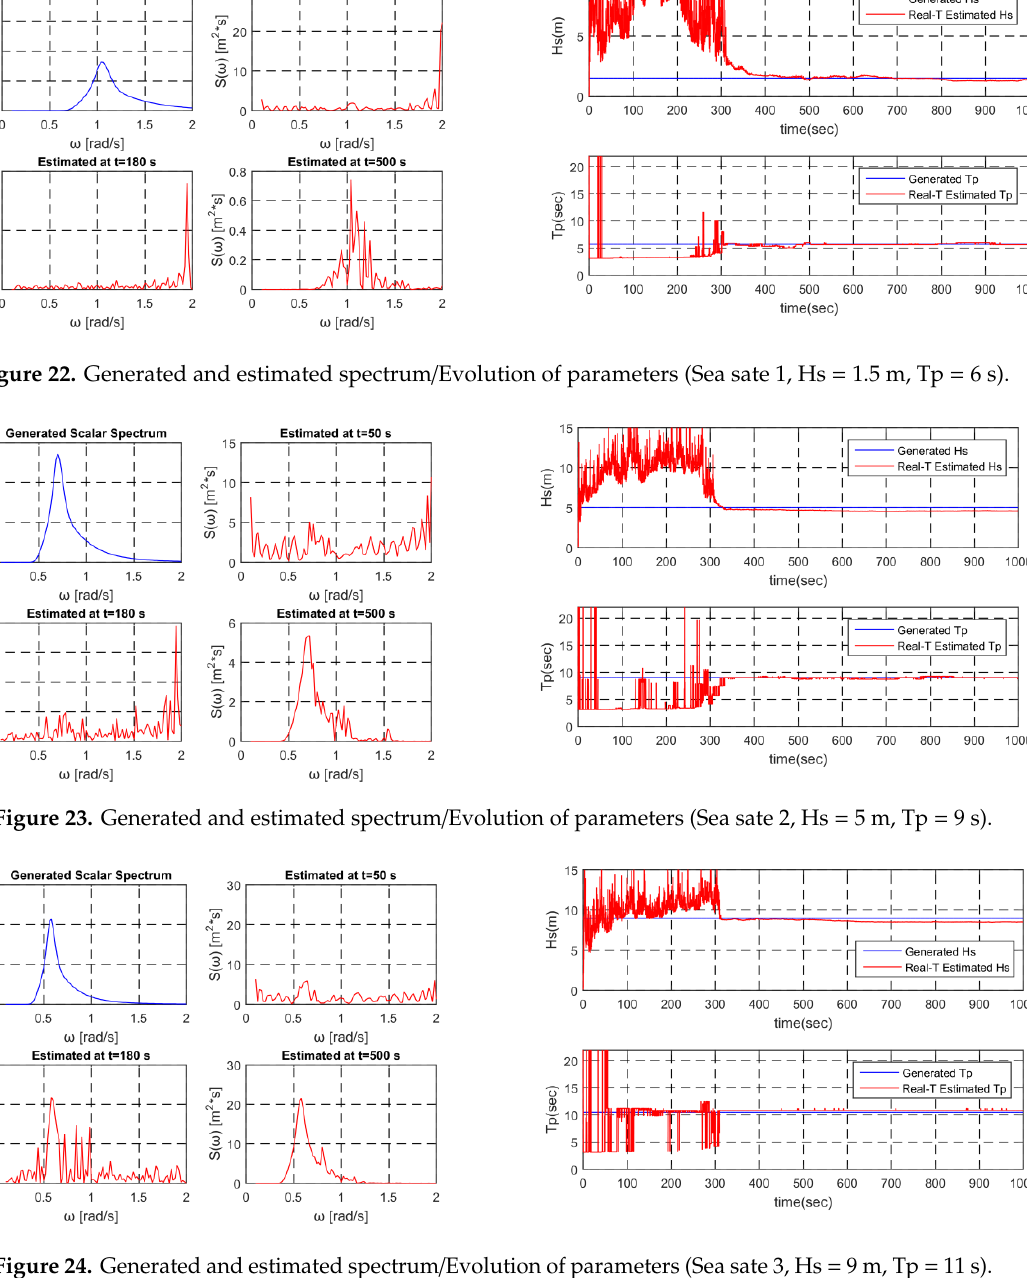
Figure 24. Generated and estimated spectrum/Evolution of parameters (Sea sate 3, Hs = 9 m, Tp = 11 s).